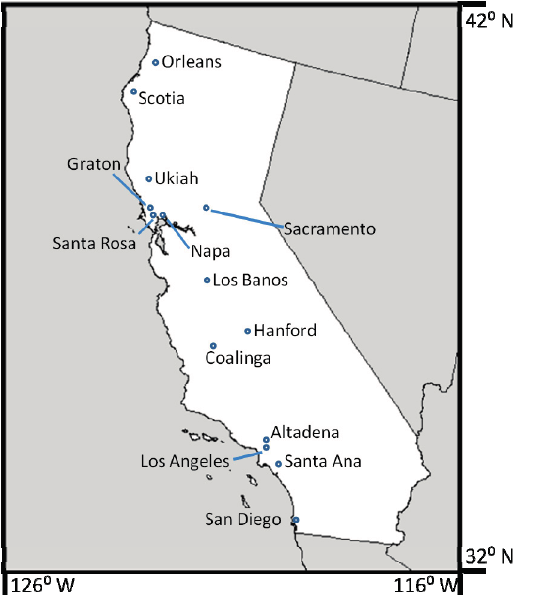
Figure 1. Index map showing station